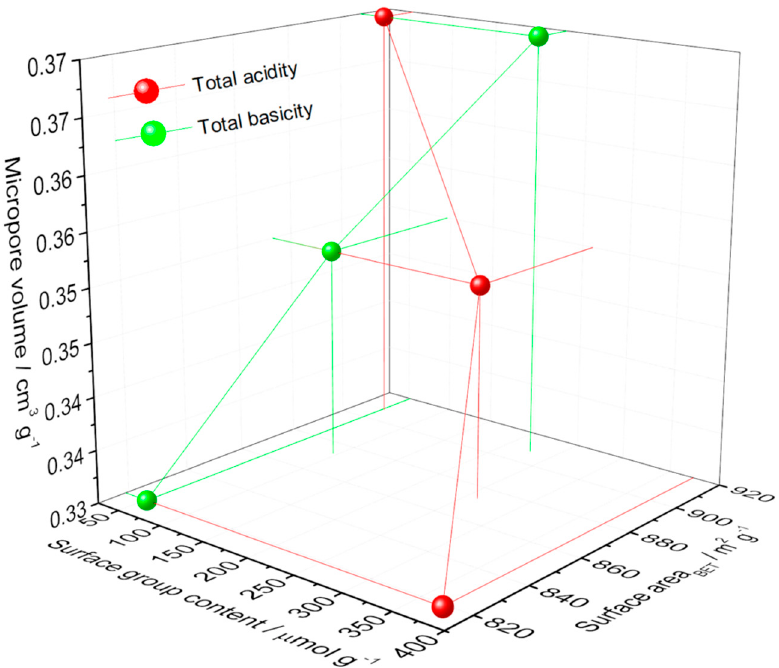
Figure 2. Relationship between the micropore volume and the surface area with the total acidity and basicity content of samples.